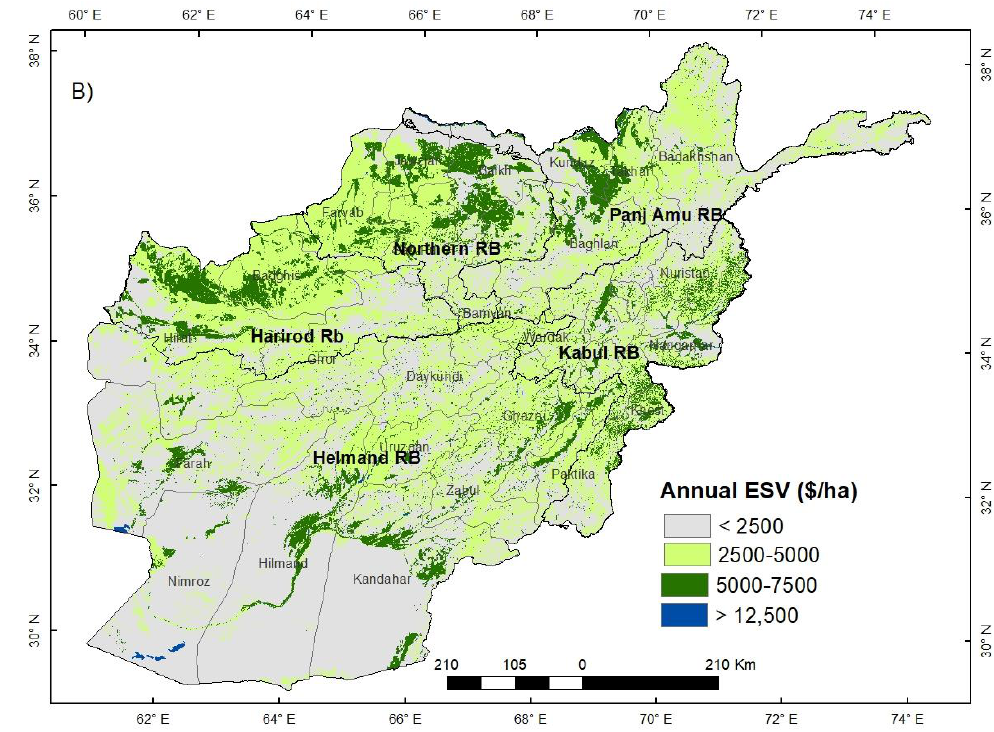
Figure 5. The spatial distribution of ESV in Afghanistan; ( A ) 2000; ( B ) 2020.